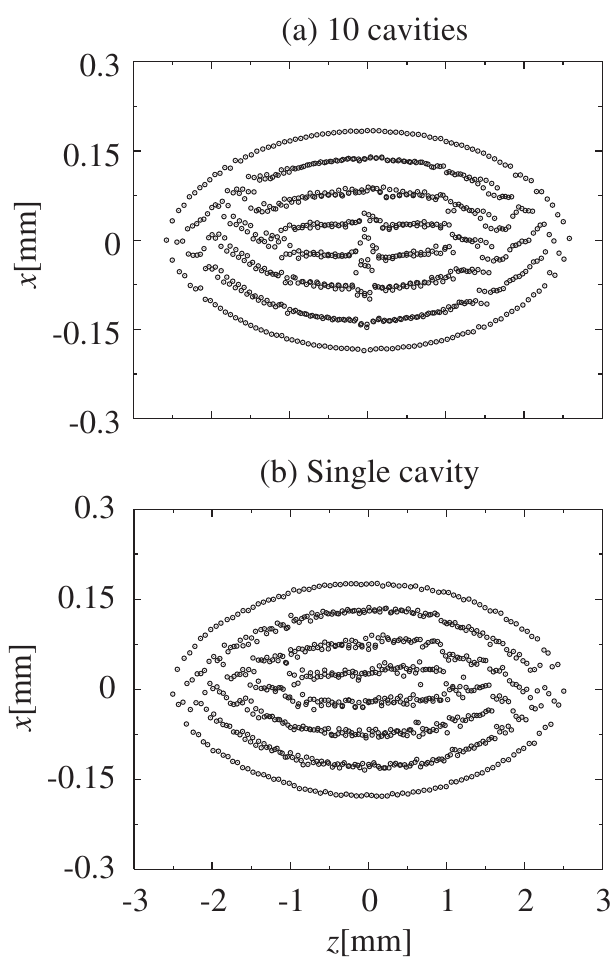
FIG. 6. Bunched 3D crystalline beams produced in Test Ring (cid:4) (cid:2) (cid:3) 1 : 46 ; 2 : 46 ; 0 : 23 (cid:4) . The ; (cid:6) ; (cid:6) II at the operating point (cid:3) (cid:6) x y z momentum dispersion has been completely suppressed in both cases. We have applied the untapered friction to 800 particles traveling at the kinetic energy of 35 keV. In the upper picture, ten rf cavities have been simultaneously excited in order to keep the 10-fold lattice symmetry, while the ring contains only a single cavity in the lower picture. Although both results look similar, the crystal of the latter case is unstable; namely, it melts in a few hundred turns after the cooling force is